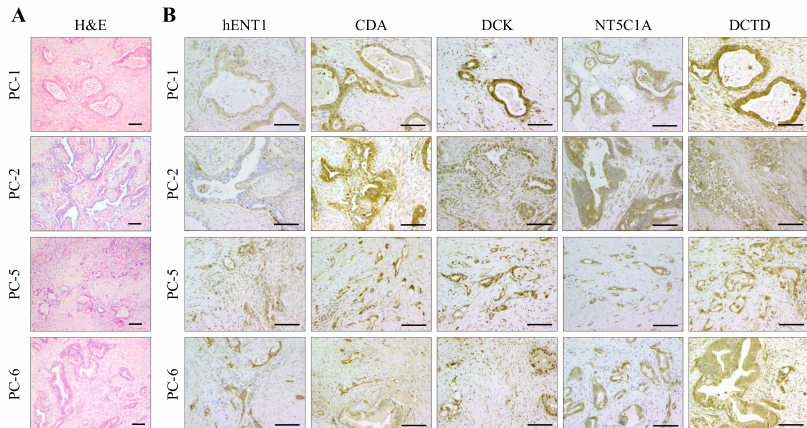
Figure 4. Morphology and expression analysis. Representative pictures from ( A ) H&E staining and ( B ) immunohistochemical staining of the source tumors from which the paired PCC and PSC cultures were obtained. Immunohistochemical pictures, showing expression of hENT1, CDA, DCK, NT5C1A, and DCTD in tumor cells. Stromal cells are occasionally weakly positive for hENT1, CDA, and NT5C1A, and up to moderately positive for DCK and DCTD. Some scattered leukocytes are positive for CDA and DCK. Scale bar = 50 µ m. CDA, cytidine deaminase; DCK, deoxycytidine kinase; DCTD, deoxycytidylate deaminase; hENT1, human equilibrative nucleoside transporter 1; NT5C1A, 5 (cid:48) -nucleotidase cytosolic 1A; PC, pancreatic cancer.